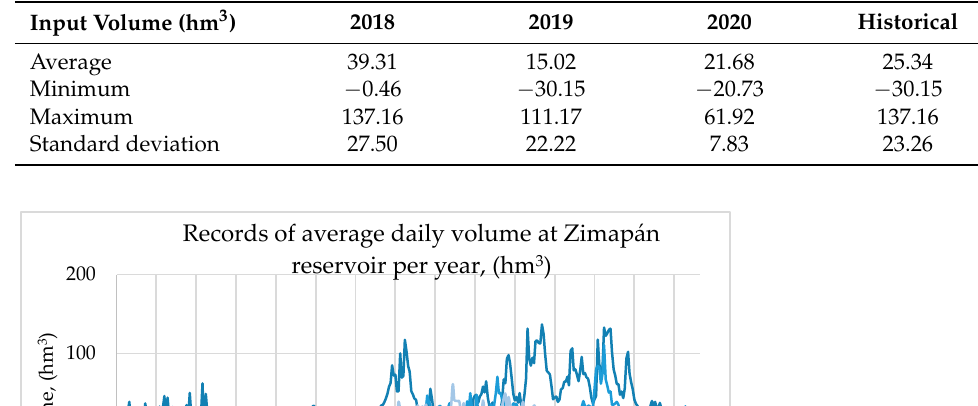
Table 3. Lower Tank Elevations-Capacities-Areas Curve.